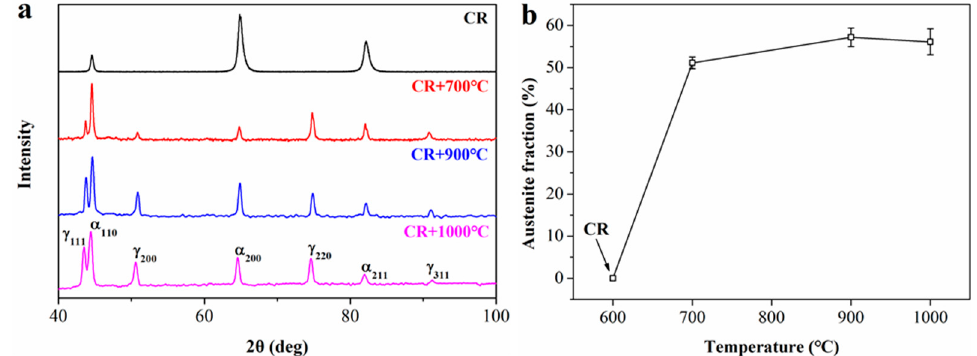
Figure 1. ( a ) Representative XRD spectrums and ( b ) the quantified austenite volume fractions of samples cold-rolled and annealed.